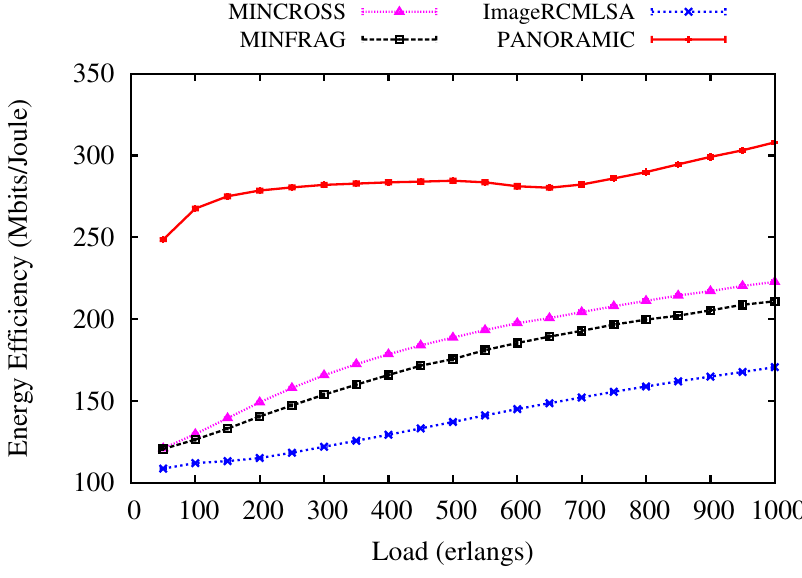
Figure 8. Energy Efficiency for NSF topology.